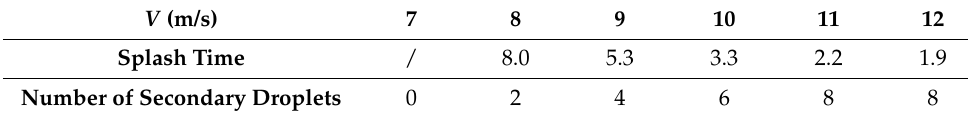
Table 2. Droplet splashing at different initial velocities (circular wire)/ μ s.